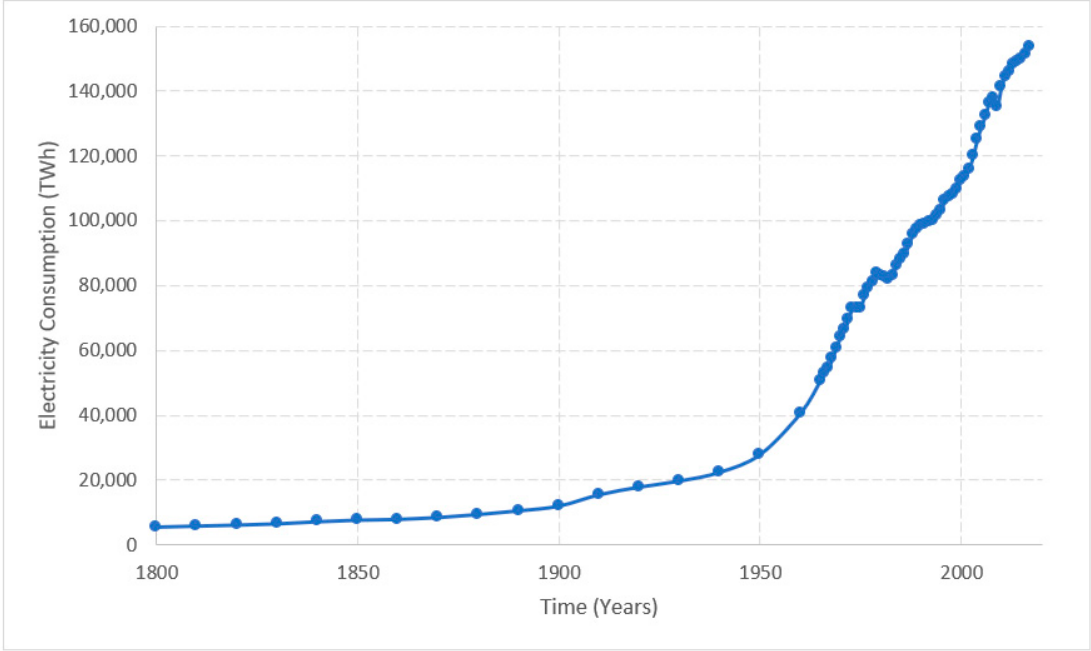
Figure 1. Historical global electricity consumption [18].